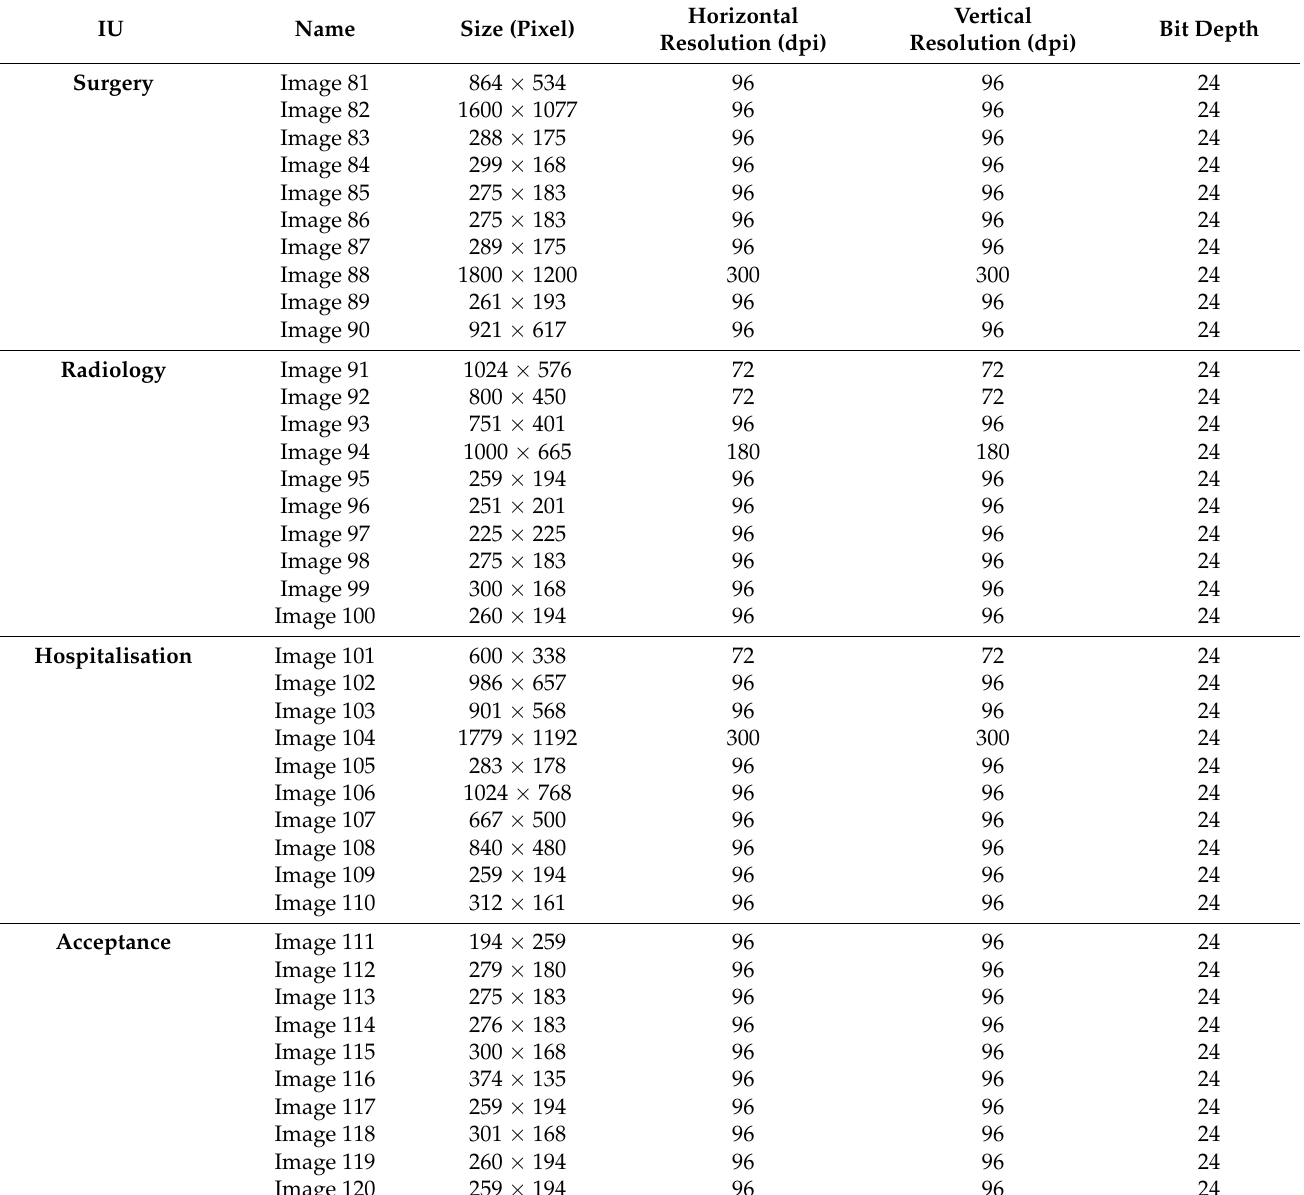
Table A6. Additional 40 images used for the second version of the model described in Section